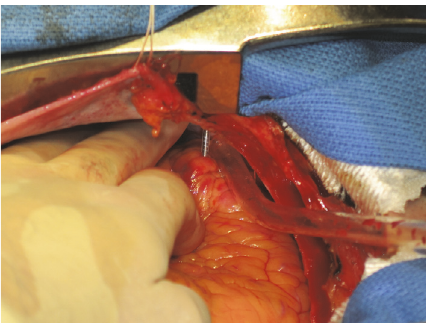
Figure 2: Chest CT reveals perforation of the right ventricle by the lead.